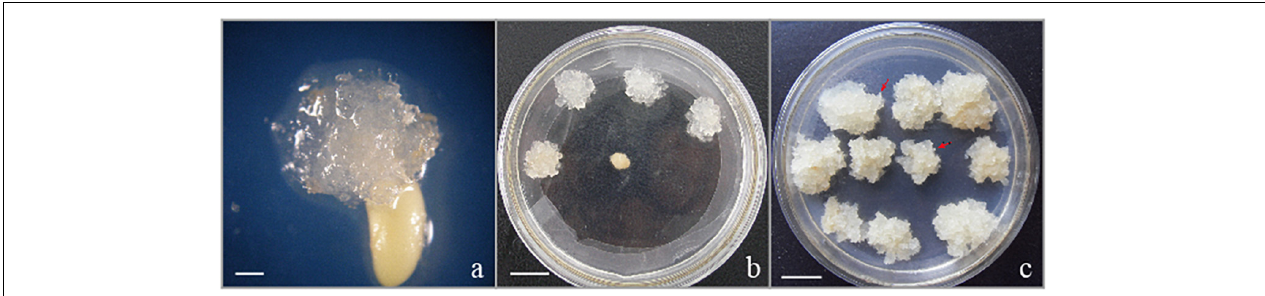
FIGURE 1 | Initiation and proliferation of somatic callus in the hybrid P. elliottii × P. caribaea . (a) Cell proliferation initiated at the micropylar end of the megagametophyte, which was the same as Liao and Amerson (1995) described. (b) Embryogenic callus subcultured on solid medium to proliferate. (c) White, transparent callus, rapid proliferation. The obvious structure of embryogenic suspensor mass composed of embryo head and highly vacuolated and elongated cells is visible under the microscope (red arrowheads). Scale bar = 1 cm.